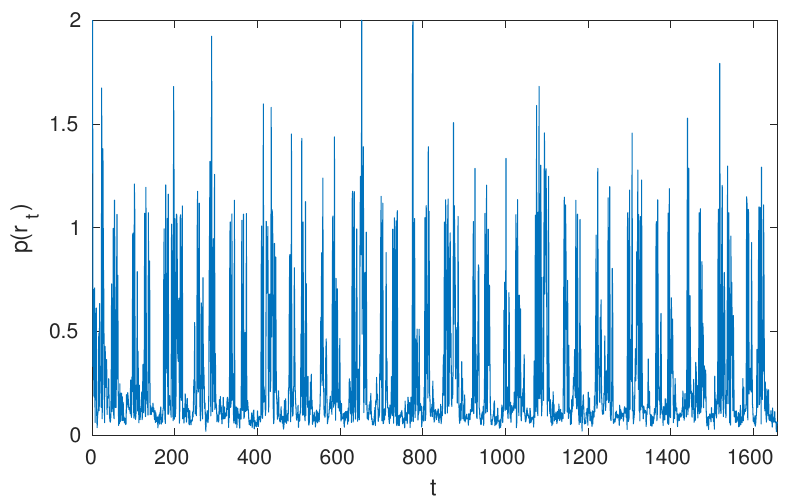
Figure 3. Approximate expectation of r t .